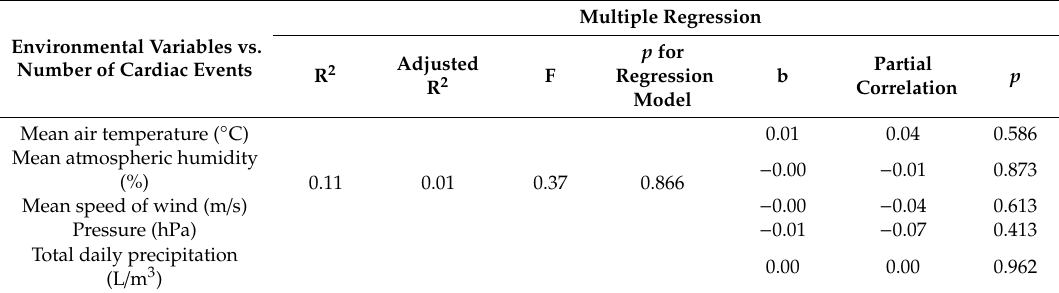
Table 7. Assessment of the number of cardiac events / number of admissions relative to the environmental variables on all days of the halny